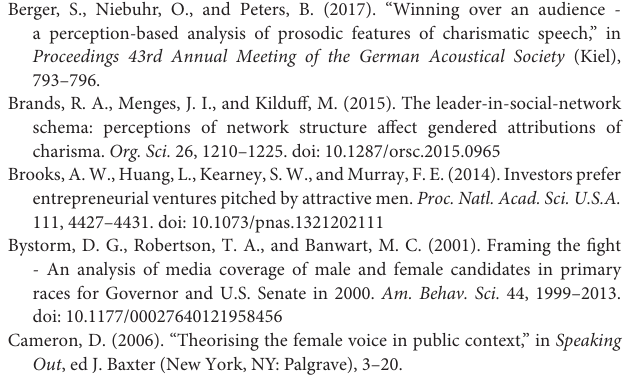
most importantly, (3) there is a gender specificity in the effect of (2). Women do benefit more from this prosody training than men. Compared to men, women’s prosodic charisma